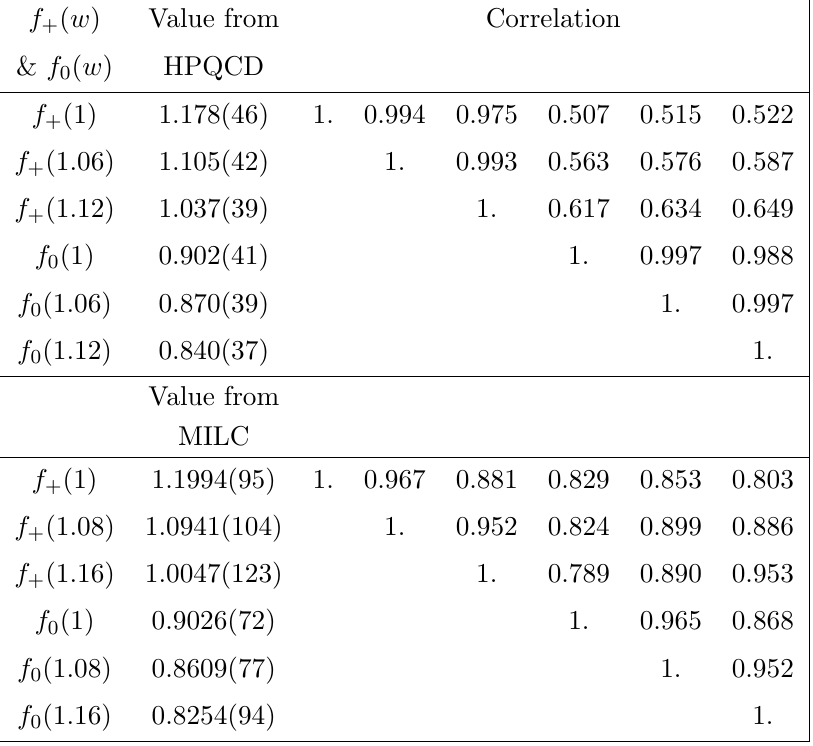
Table 1 . Lattice QCD results of f + and f 0 for di(cid:11)erent values of w . The upper half of the table have been obtained using the (cid:12)t results from the HPQCD collaboration [18], and the lower half are the results obtained by the Fermilab MILC collaboration